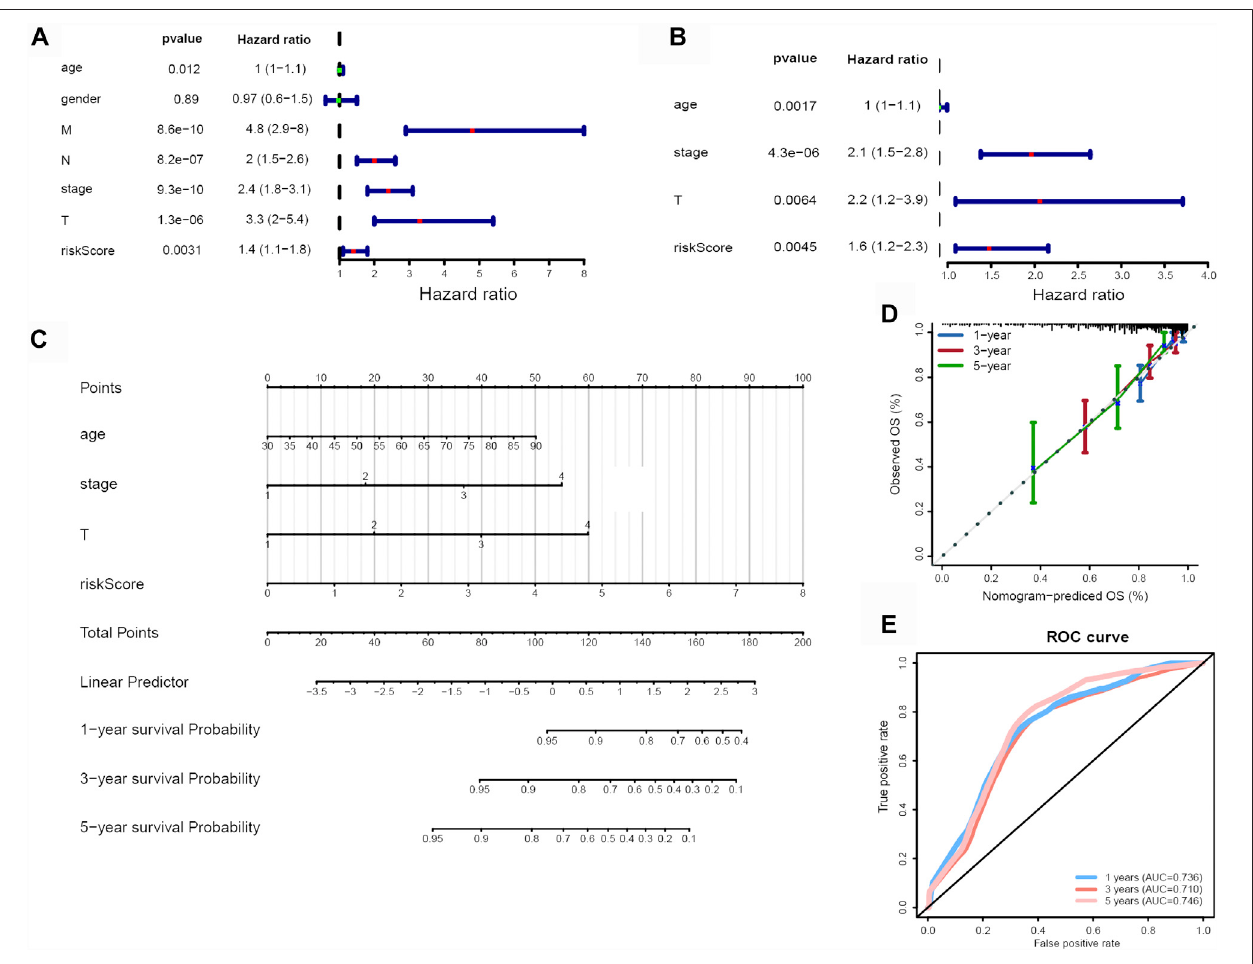
FIGURE 6 | Identi fi cation of independent risk factors and construction of a nomogram. (A) The univariate and (B) multivariate Cox regression analysis of risk score and clinical feature prognostic value. (C) A nomogram was constructed to predict 1-, 3-, and 5-years OS using risk score, stage, T and age. (D) Calibration curves of nomogram. (E) 1-, 3-, and 5-years ROC curve based on nomogram.